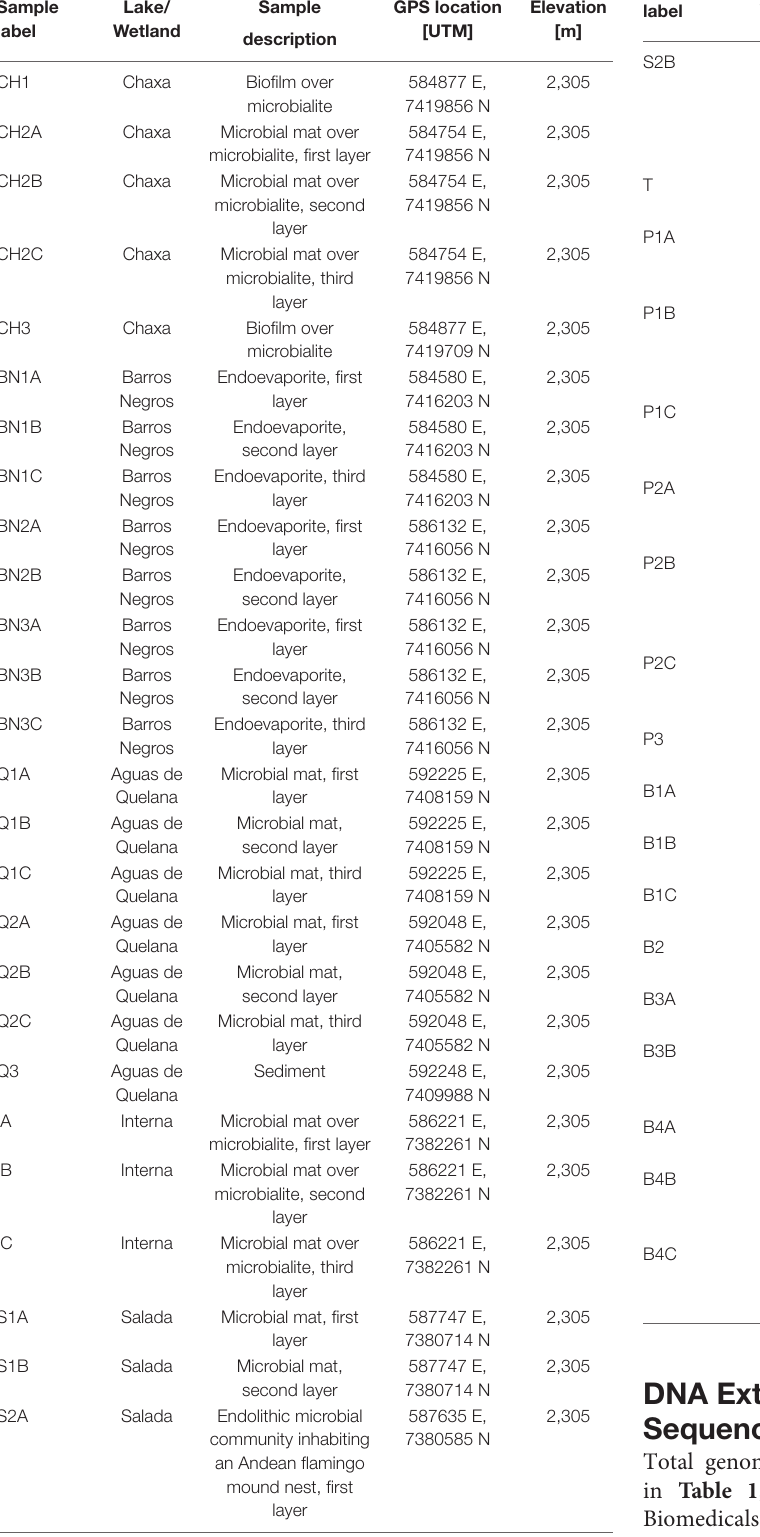
TABLE 1 | Overview of samples used to perform 16S rRNA diversity analyses, locations and coordinates. Sample